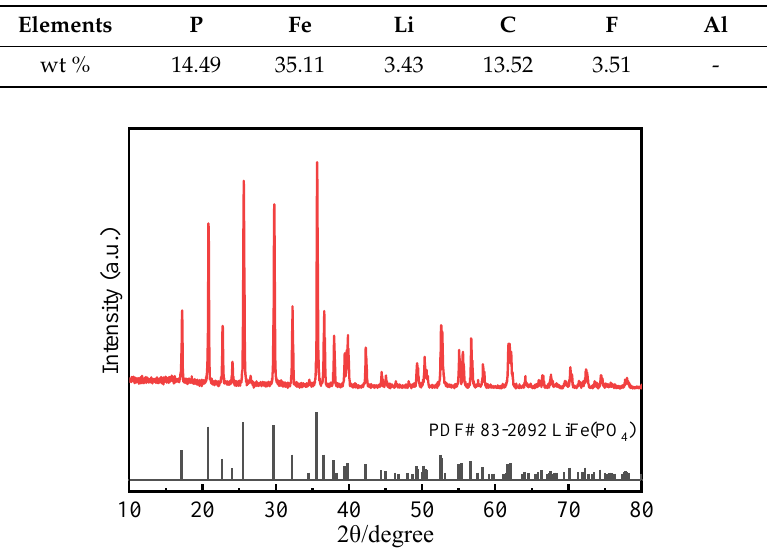
Figure 2. XRD pattern of the raw cathode materials.